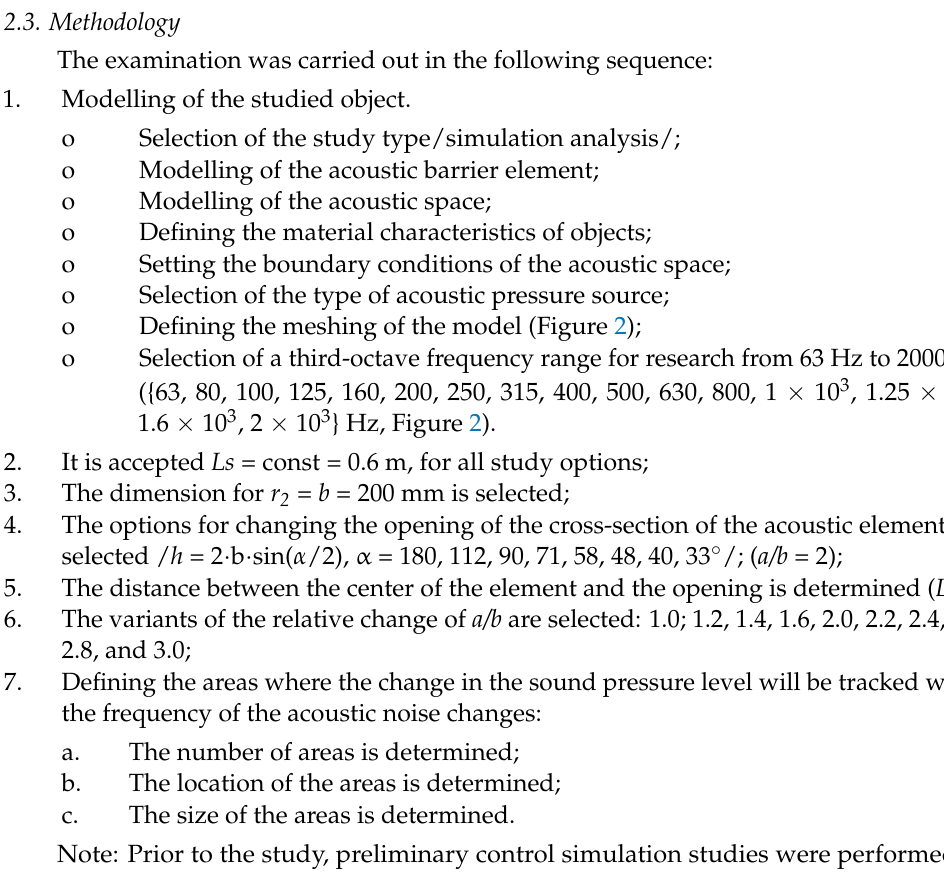
Figure 3. Boundary conditions and objects in the model.